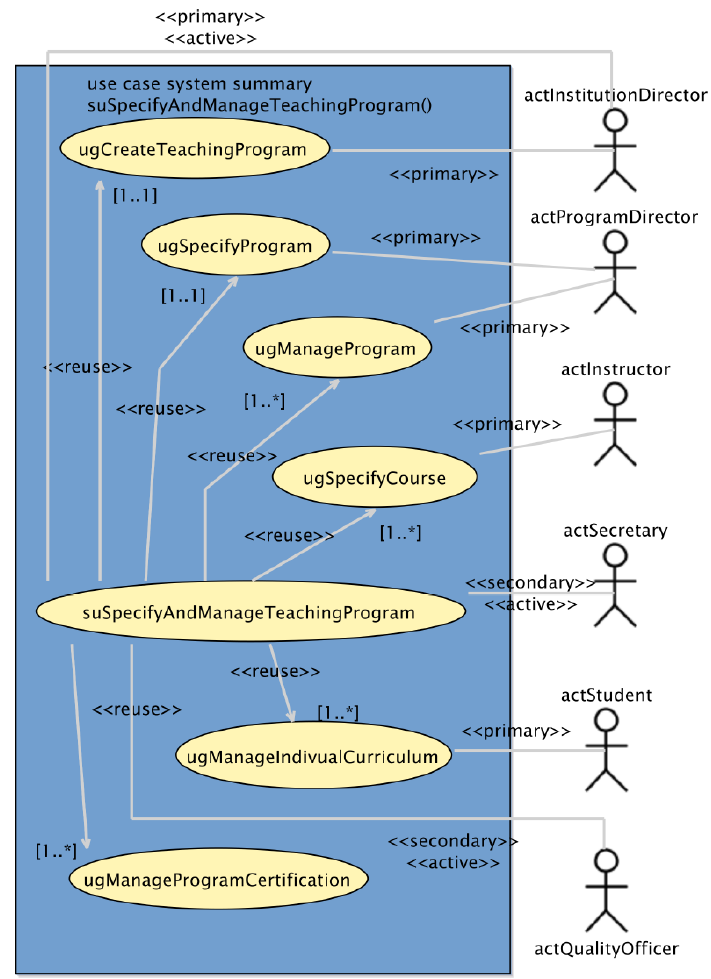
Figure 1. TESMA summary use-case model.